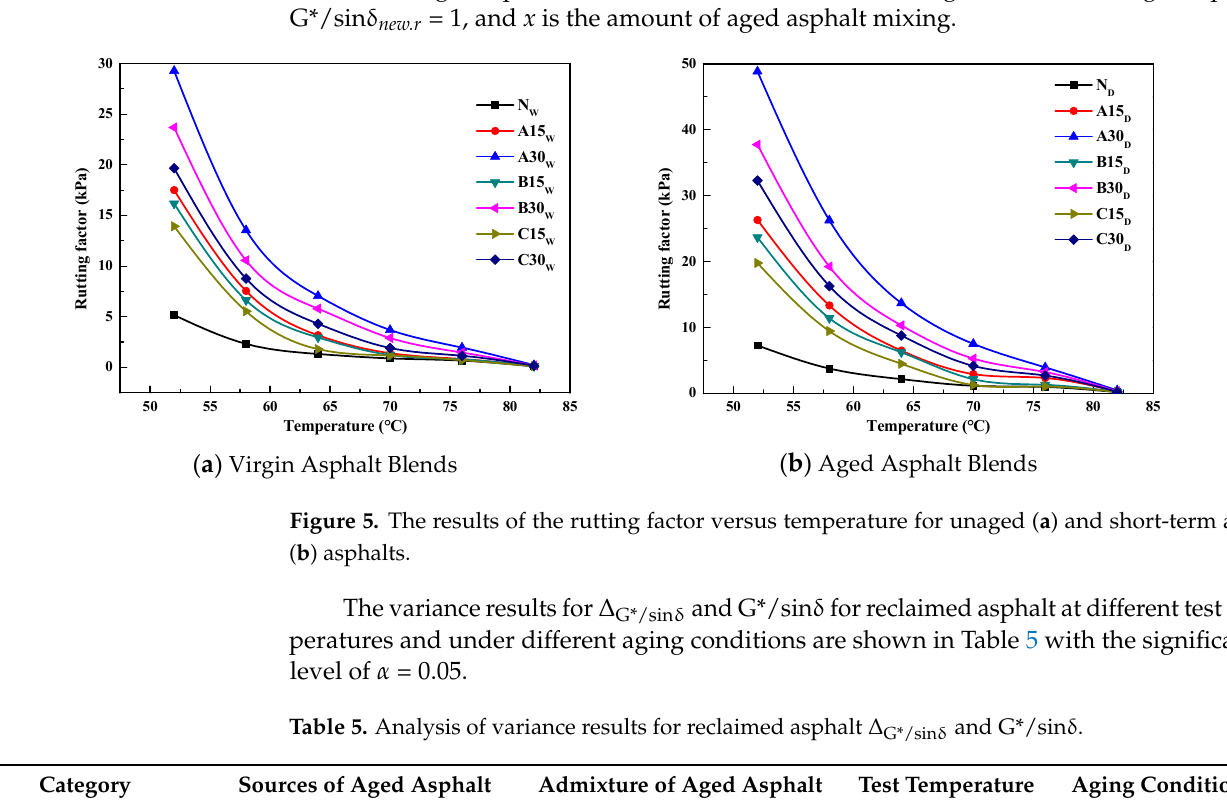
Table 5. Analysis of variance results for reclaimed asphalt ∆ G*/sin δ and G*/sin δ